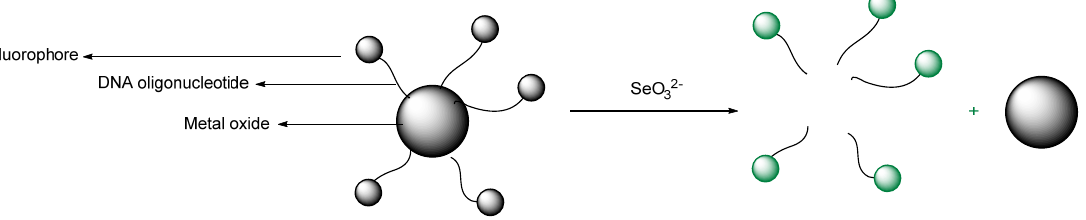
Figure 68. The probing of selenite based on the nanodevice structure and strategy discussed by Yu et al. Gallium selenide materials with Ce and Er doping were prepared; Ultrafast dynam-